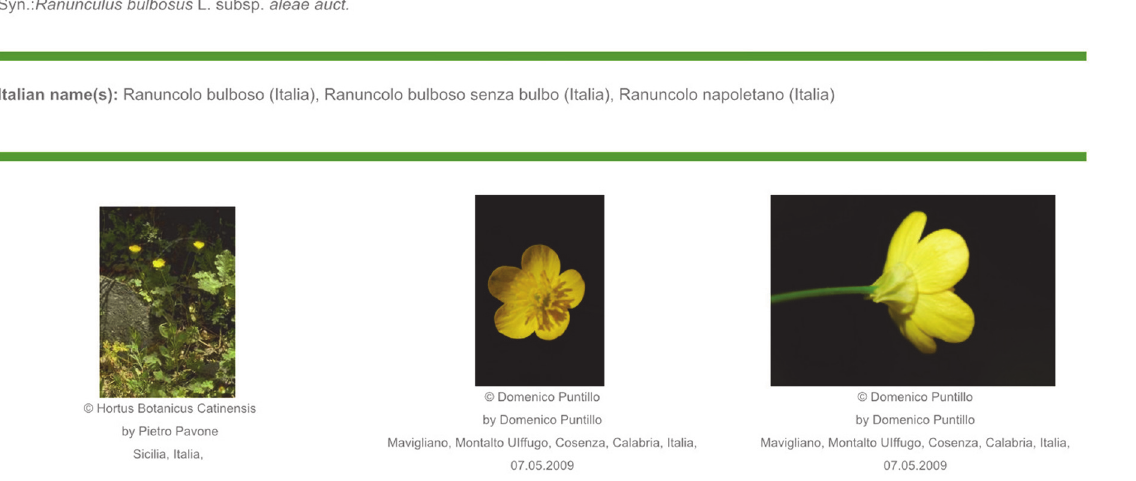
Fig 10. Taxon page. It lists scientific name, synonyms (when present), family and its position in the APG III system, an image, a distribution map in the regions of Italy, vernacular names, a note, and a gallery of